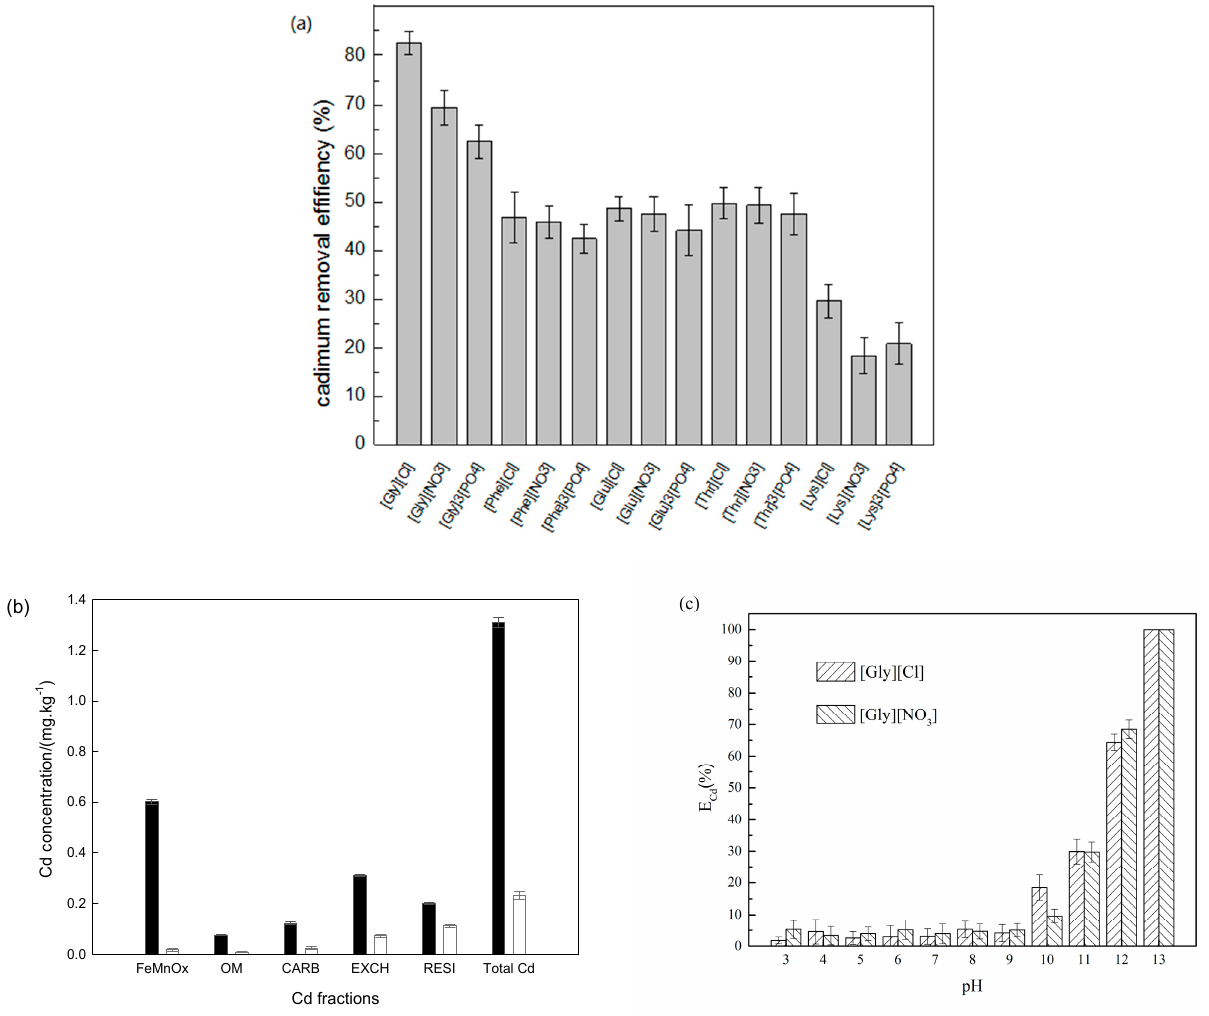
Figure 2. ( a ) Percentage Cd removal by different ILs; ( b ) distribution of Cd fractions in the soil before and after washing with [Gly][Cl]. The black and white bars represent soil before and after washing, respectively; ( c ) Cd removal percentage in washing wastewater with [Gly][Cl] at different pHs. [Gly][X] had the highest E% (62.5–74.5%), possibly because [Gly] + has excellent solu- bility and exhibits little steric hindrance, as [Gly] + is the smallest cation. For [Phe][X],